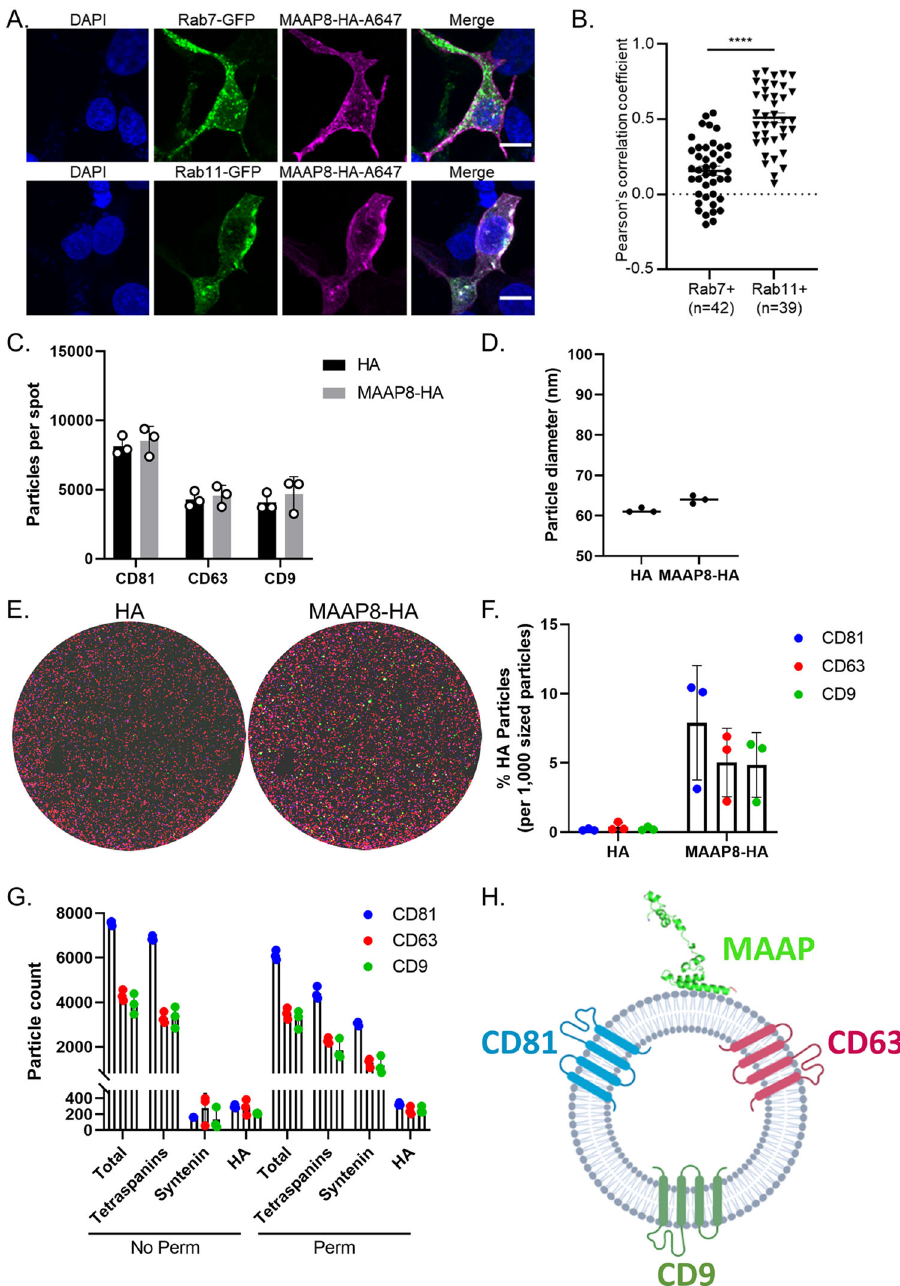
Fig. 6 MAAP interacts with the surface of extracellular vesicles. A HEK293 cells were transfected with expression vectors encoding Rab7-GFP, Rab11- GFP, MAAP8-HA. MAAP-HA was detected by immuno fl uorescence with an AlexaFlour647 secondary antibody (MAAP8-HA-A647). A Z-stack of confocal optical sections at 1- μ m steps was acquired. A 3- μ m-thick medial stack is shown. Images are representative of three experiments. Scale bars, 10 μ m. B Co-localization between MAAP8-HA and Rab7-GFP or Rab11-GFP in the whole cell as assessed by Pearson ’ s correlation coef fi cient ( R ) as described in Materials and Methods. Each dot represents one cell. Horizontal bars represent the mean ± SEM. A two-sided Mann – Whitney rank test was used to determine signi fi cance. (Rab7 + vs Rab11 + , **** p < 0.0001). C Chips coated with separate capture spots for anti-CD81, anti-CD63, and anti-CD9 were used to capture EVs from media of cells expressing CMV-HA and CMV-MAAP8-HA. Total captured EVs on each chip were quanti fi ed ( n = 3). Data are presented as mean values ± SD. D Representative size distribution pro fi le of tetraspanin-positive EVs determined by label-free interferometry ( n = 3). E CD81 capture probe images of EVs captured from media of cells expressing CMV-HA and CMV-MAAP8-HA. EVs were probed with anti-CD81-CF488a (blue), anti-HA-Alexa Fluor 555 (green), anti-CD9-CF647 (red), and anti-CD63-CF647 (red) ( n = 3). F Quanti fi cation of percent HA labeled EVs captured from media of cells expressing CMV-HA and CMV-MAAP8-HA ( n = 3). Data are presented as mean values± SD. G EVs from media of cells expressing CMV-MAAP8-HA were captured with anti-CD81, anti-CD63, and anti-CD9 coated chips. EVs were fi xed, permeabilized and probed with anti-HA-Alexa Fluor 555 to determine the EV loading orientation of MAAP8-HA ( n = 3). Data are presented as mean values ± SD. H Cartoon schematic depicting EV surface loading of